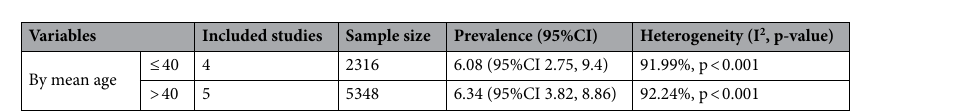
Table 3. Subgroup pooled prevalence of undiagnosed DM based on age of the participant in Ethiopia, 2021 (n = 9).